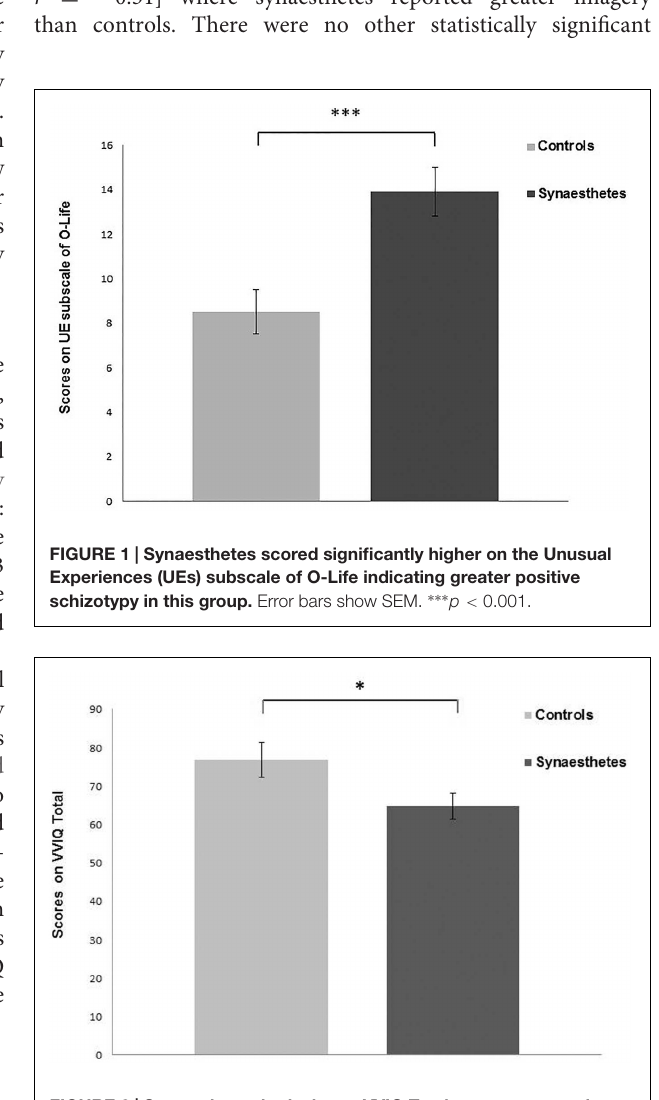
FIGURE 2 | Synaesthetes had a lower VVIQ Total score compared to controls indicating greater self-reported imagery in this group. Error bars show SEM. ∗ p <